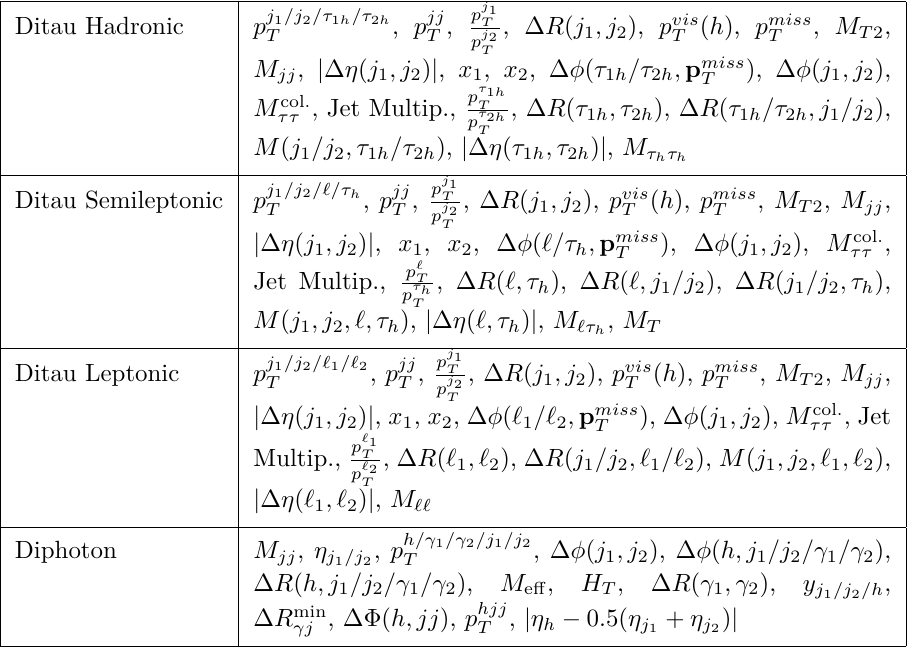
Table 6 . Parameters which are used in corresponding NN training. Observables shown with comma, O i,j , represents a system of corresponding i th leading and j th leading particles and the ones shown with slash, O i/j , represents the usage of the same observable for both i th leading and j th leading reconstructed object